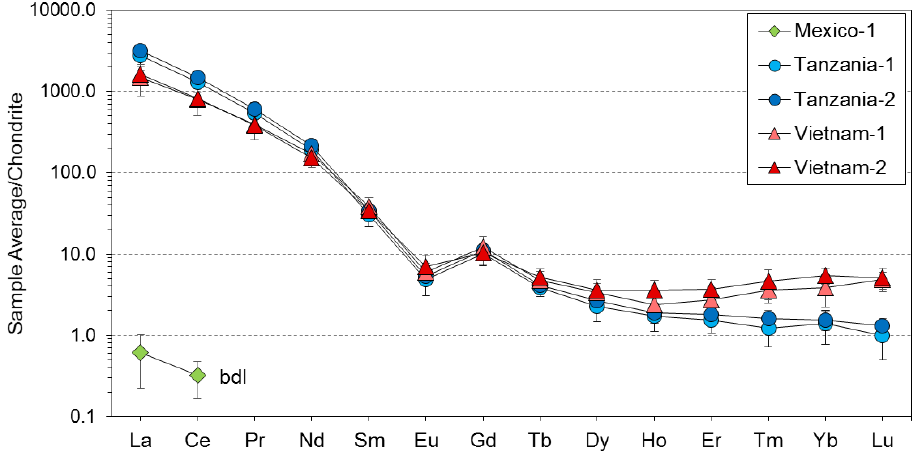
Figure 1. Rare earth element (REE) mass fractions in danburite from Mexico, Tanzania, and Vietnam. All values are presented as averages and normalized to C1-chondrite (data from [20]). Samples from Tanzania and Vietnam have a high abundance of REEs, especially LREEs, while samples from Mexico are largely devoid of these elements (bdl, below detection limit, from Pr to Lu).